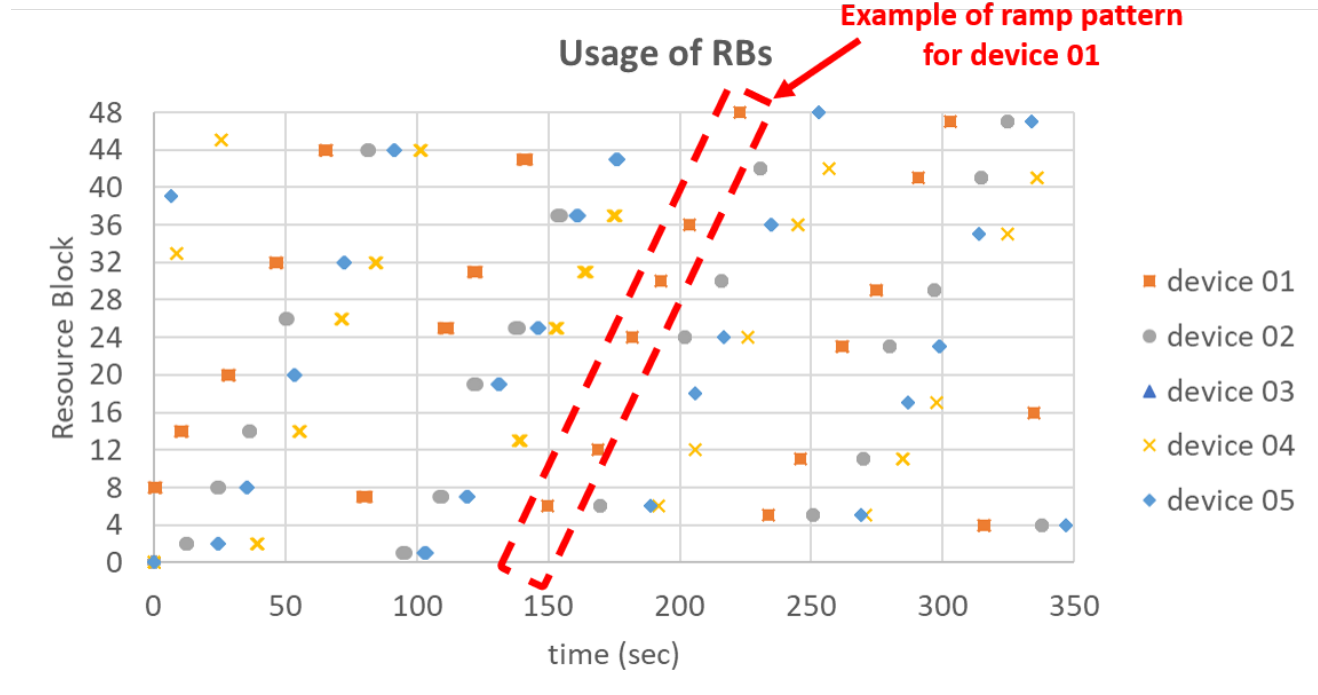
Figure 15. Resource blocks usage in the proof-of-concept (only 5 nodes